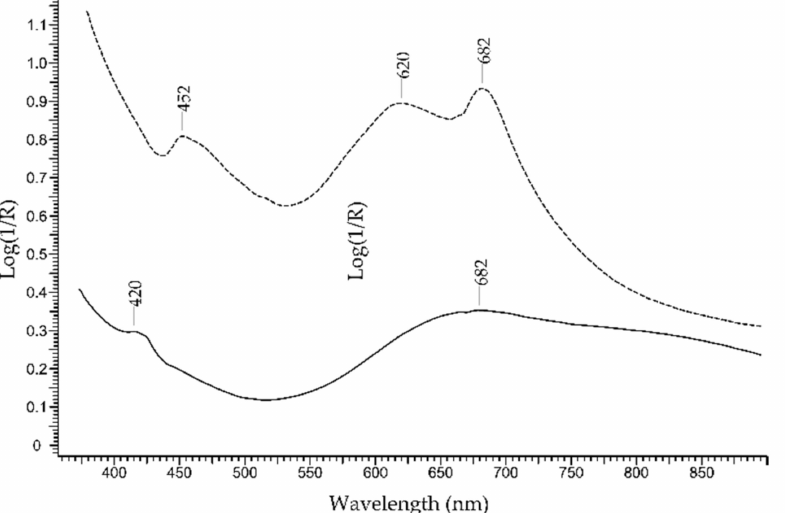
Figure 5. FORS spectra in Log(1/R) coordinates of a natural turquoise (solid line) and a dyed turquoise (dashed